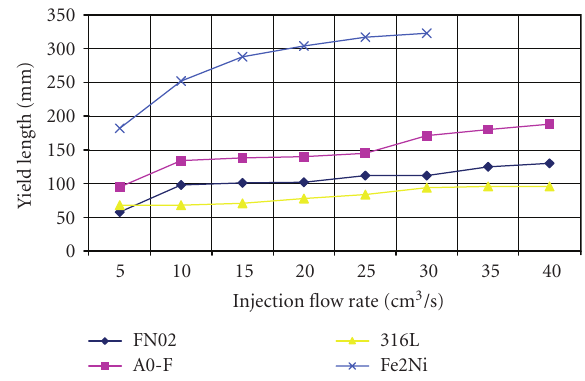
Figure 11: Yield length versus flow graph for feedstocks.